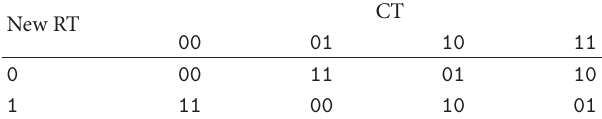
Table 6: The ROM formed for Table